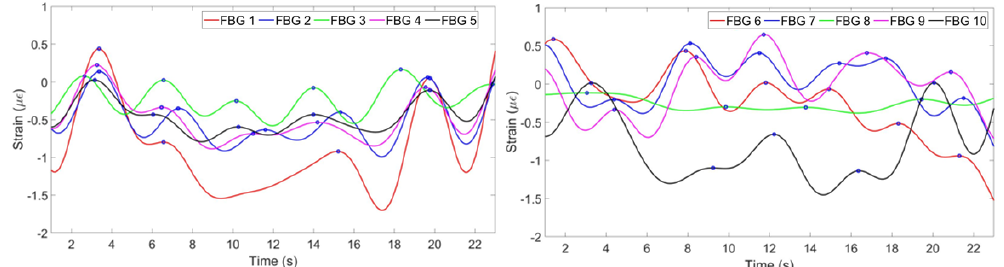
Figure 10. Breathing pattern for the first volunteer in the staying position detected by FBGs on the chest ( left ) and abdomen ( right ) regions.